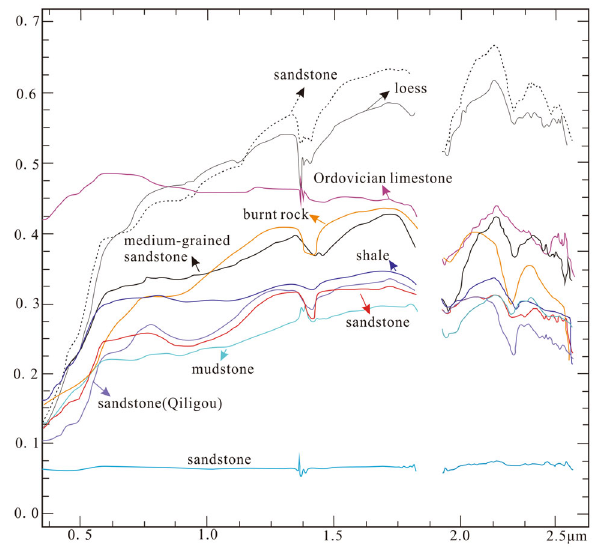
Fig. 1 Spectral curve of common rocks in coal bearing